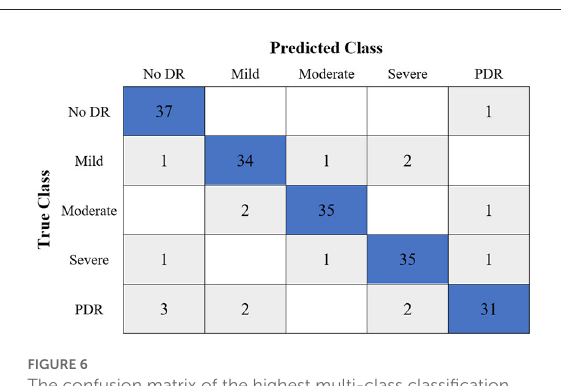
FIGURE6 The confusion matrix of the highest multi-class classification outcome for the GWO-ELM approach using the APTOS-2019 dataset.